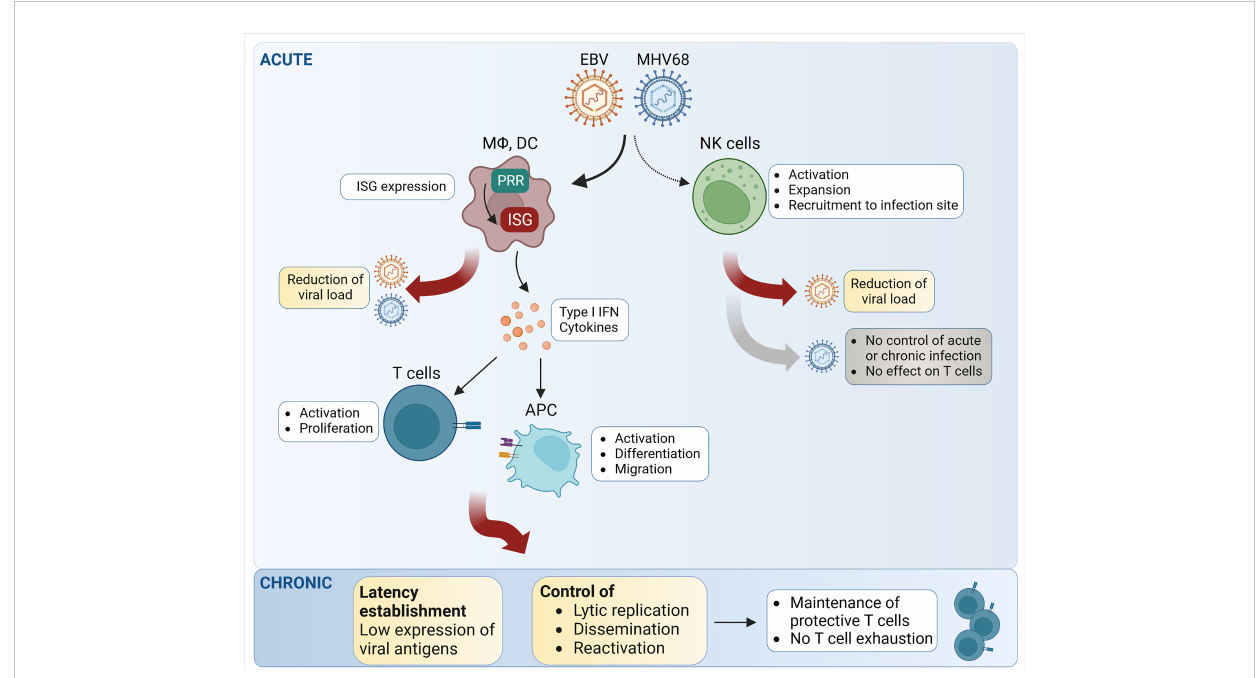
FIGURE 2 Schematic representation of the main steps of NK- and T cell-mediated control of EBV and MHV68 infection. During acute infection, both EBV and MHV68 trigger natural killer (NK) cell activation, recruitment and expansion. However, the relative impact on the control of MHV68 infection and MHV68-triggered T cell responses appears limited, while NK cells seem to have an effect on EBV replication. Upon detection of EBV and MHV68, pattern recognition receptors (PRR) induce the expression of interferon-stimulated genes (ISG), which exert direct effects on critical steps of the viral life cycle. By inducing type I IFN and proin fl ammatory cytokine secretion, EBV and MHV68 can trigger important downstream effects leading to T cell activation and T cell proliferation. During chronic infection, the type I IFN response and T cells both contribute to the control of latency and reactivation. APC, antigen-presenting cells; DC, dendritic cells; M F , macrophages. Created with